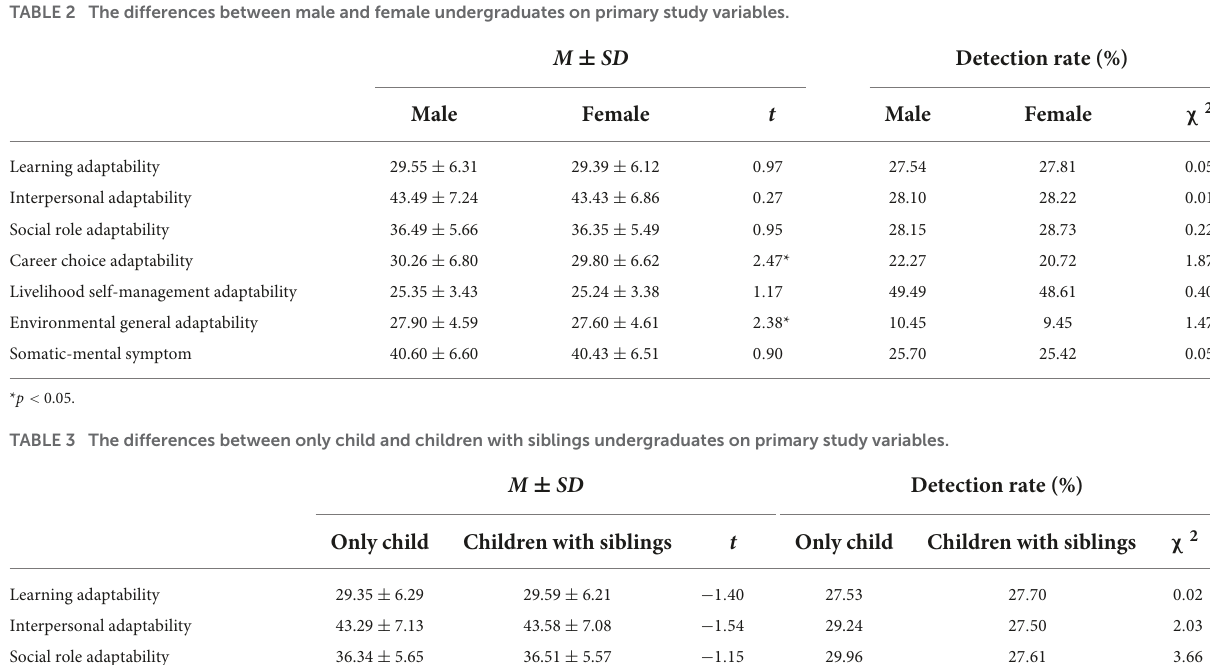
TABLE 2 The differences between male and female undergraduates on primary study variables.